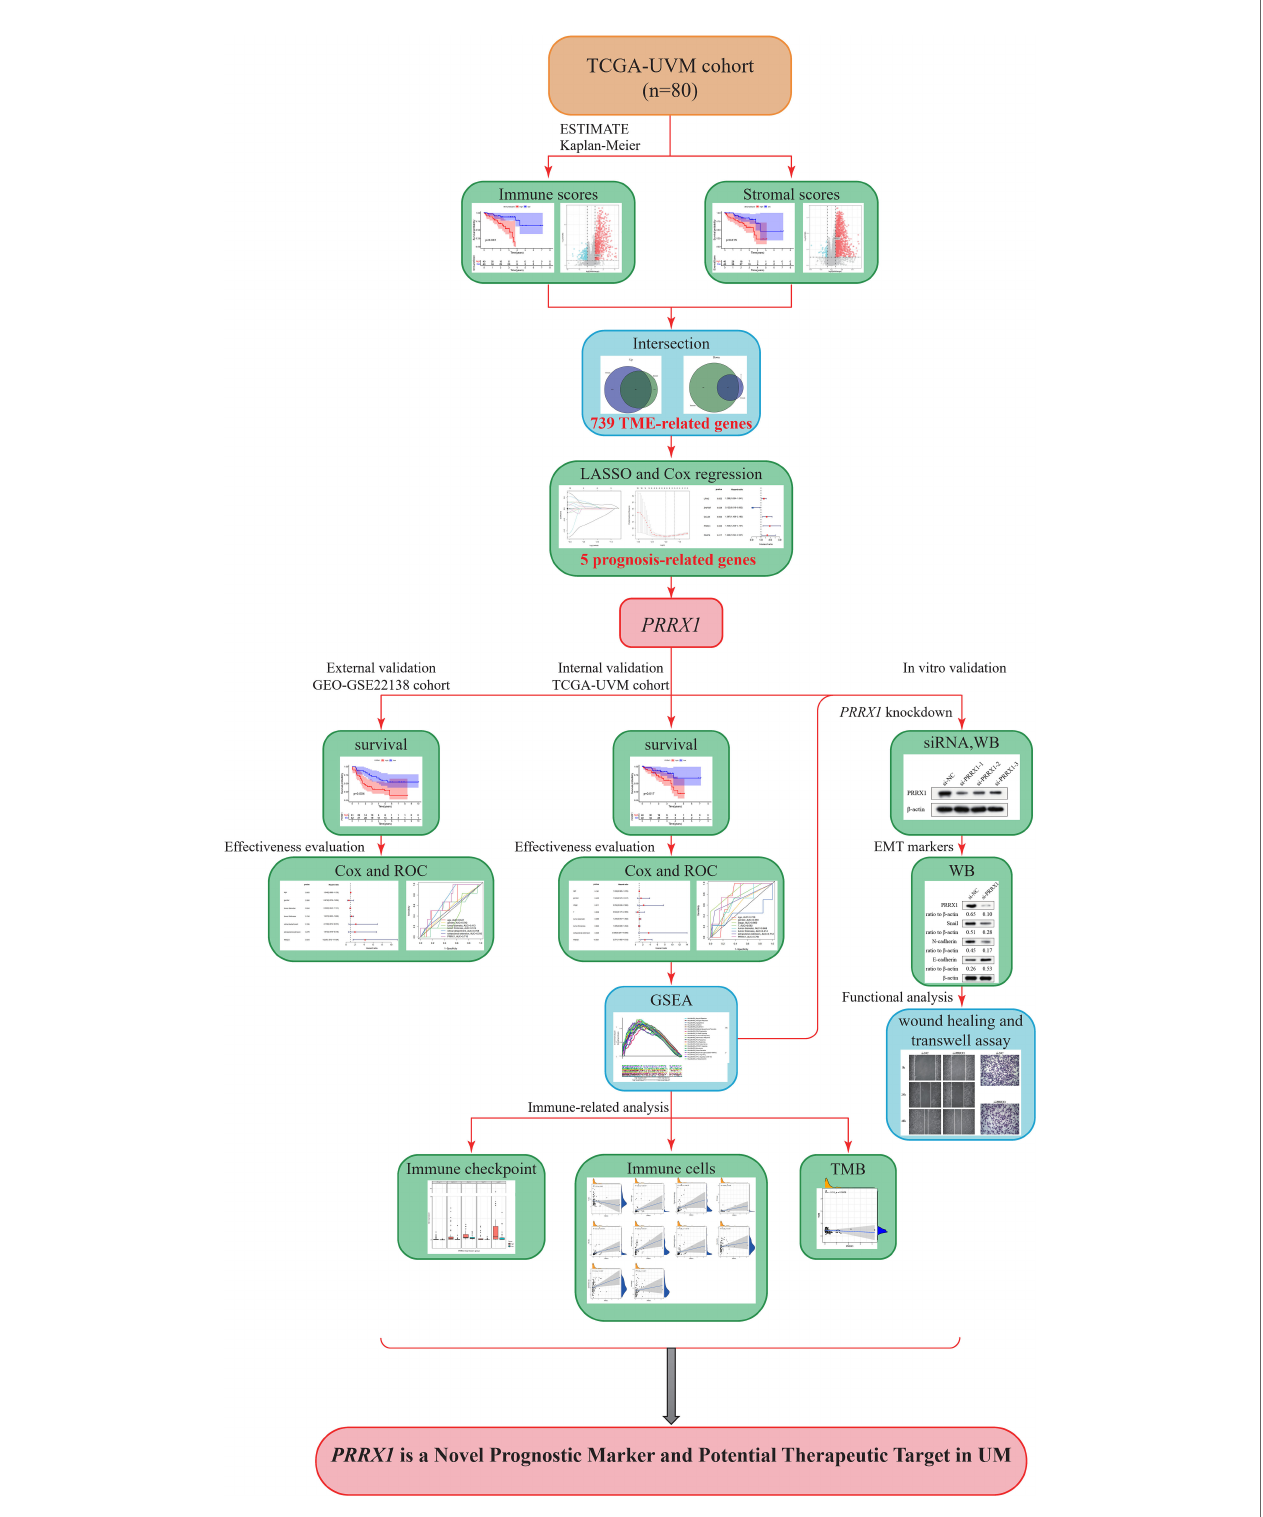
FIGURE 1 | Study fl ow diagram. UVM/UM, uveal melanoma; TCGA, The Cancer Genome Atlas; TME, tumor microenvironment; LASSO, least absolute shrinkage and selection operator; PRRX1, paired related homoeobox 1; ROC, receiver operating characteristic; WB, Western blot; siRNA, small interfering RNA; GSEA, Gene Set Enrichment Analysis; GEO, Gene Expression Omnibus; TMB, tumor mutation